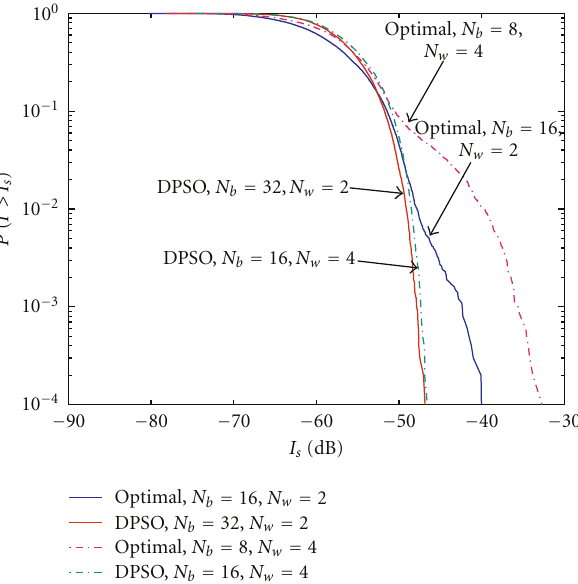
Figure 11: DPSO PTS-AIC with a larger N b than that of the optimal